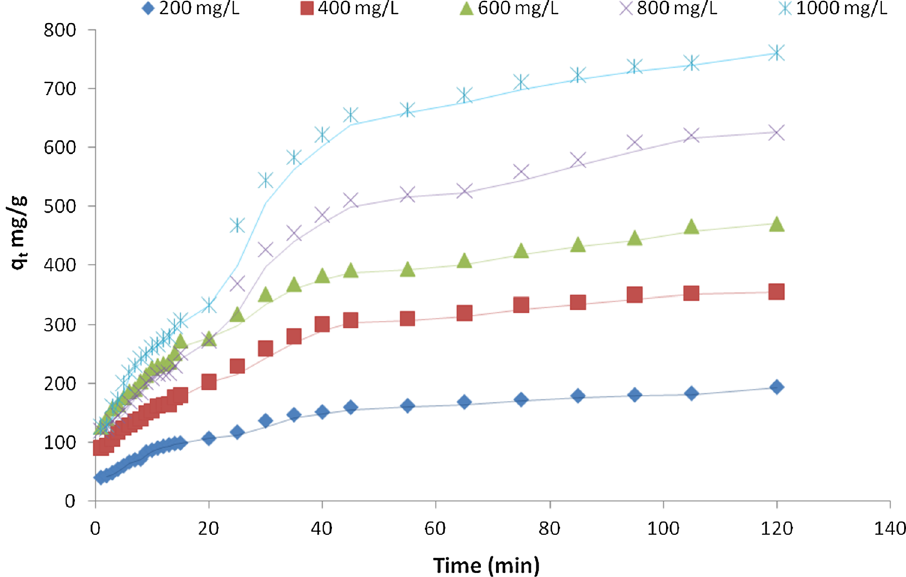
Fig. 5 Effect of contact time and initial Rh-B dye concentra- tion on CHA at 323